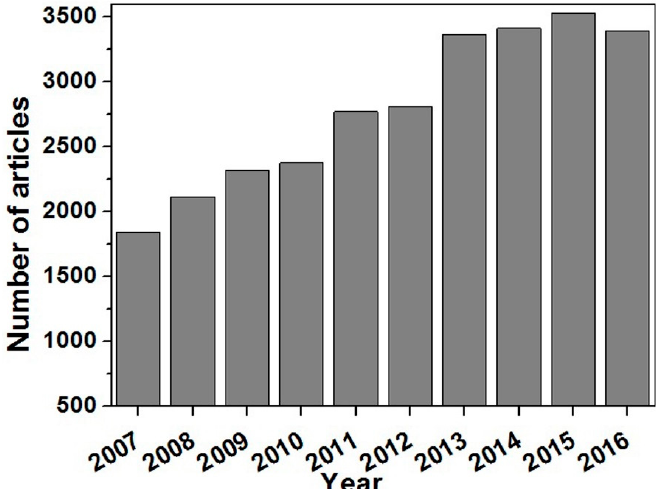
Figure 1. Number of articles published on ECL biosensors in the last 10 years with the keyword search of “electrochemiluminescence biosensor”, either in the title or in the abstract [26].